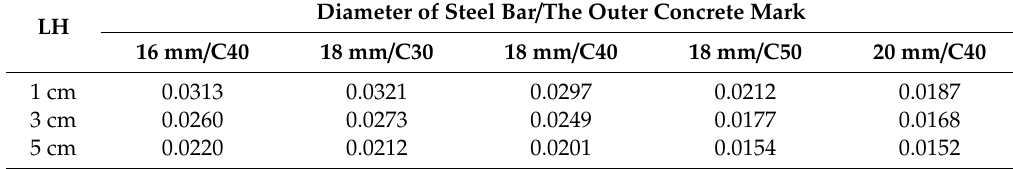
Table 4. Linear section slopes of the S D – T diagrams of SBCC specimens with di ff erent strengths of outer concrete and di ff erent-diameter steel bars. Diameter of Steel Bar / The Outer Concrete LH